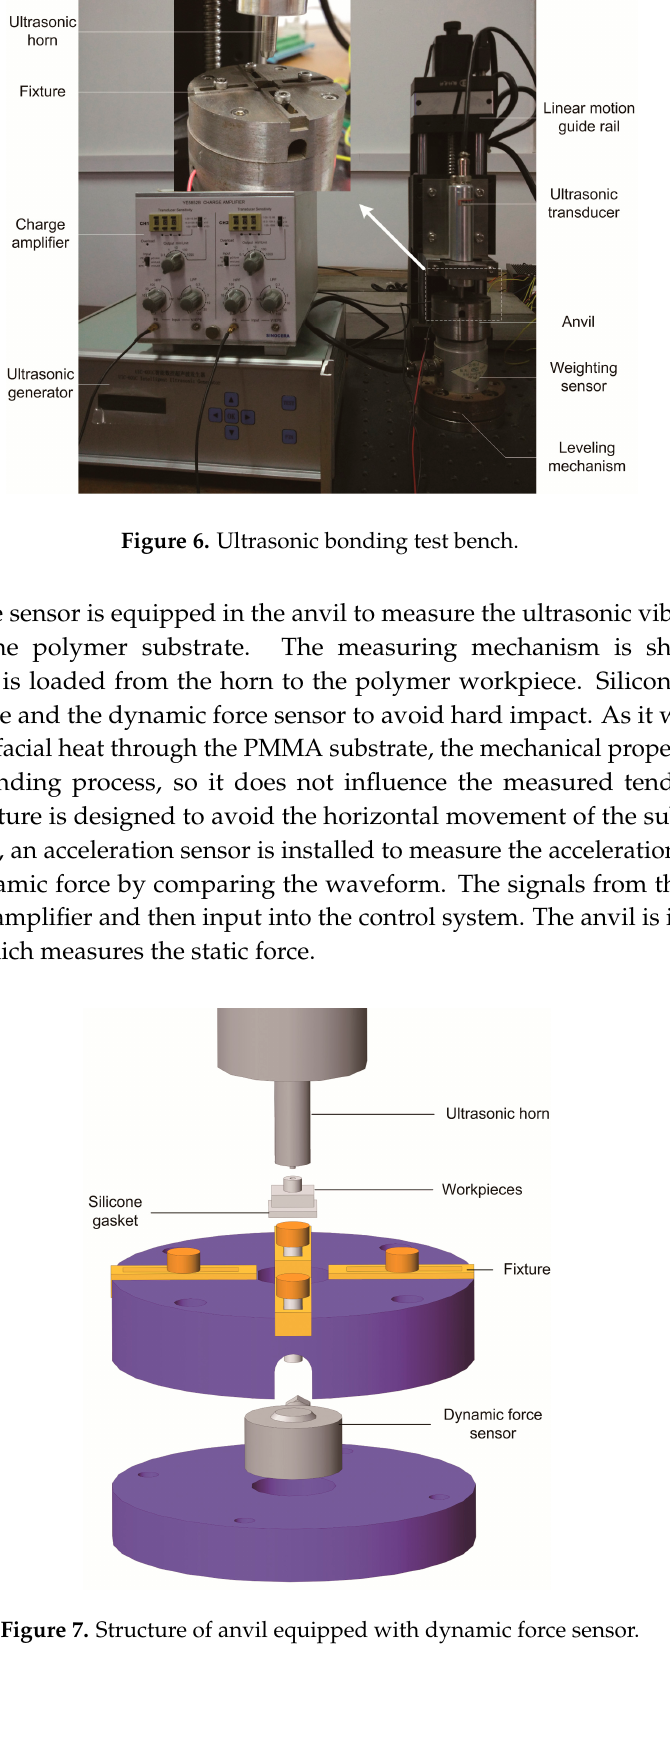
Figure 7. Structure of anvil equipped with dynamic force sensor.